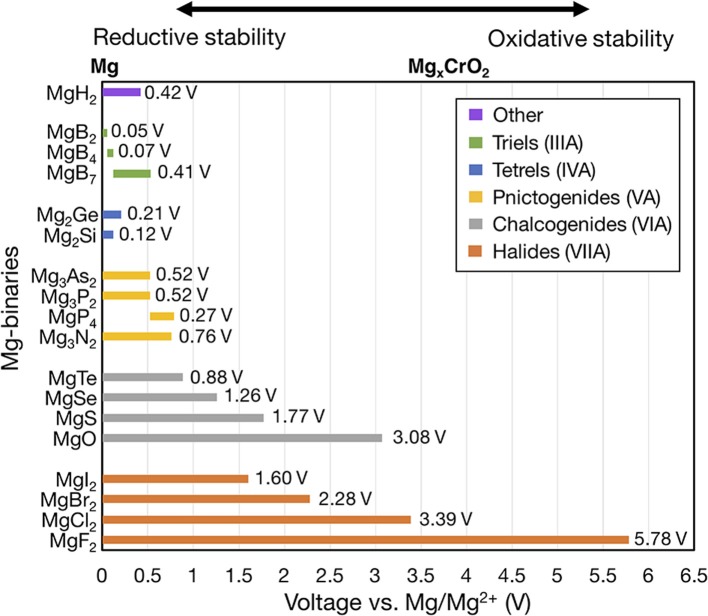
Electrochemical stability windows of non-metallic Mg-binaries, indicating the voltages (vs. Mg metal) at which the compound is stable against decomposition. Compounds that are not stable at any voltage, such as the Mg-carbides, are not shown. Compounds are grouped by the anion column and compounds within each group are ordered by increasing electronegativity. For systems with multiple compositions, compounds are ordered by decreasing ratio of Mg to anion. The number at the end of each bar indicates the width of the voltage window. The MgxCrO2 spinel is shown above the plot at its calculated average voltage (~3.6 V) for reference.